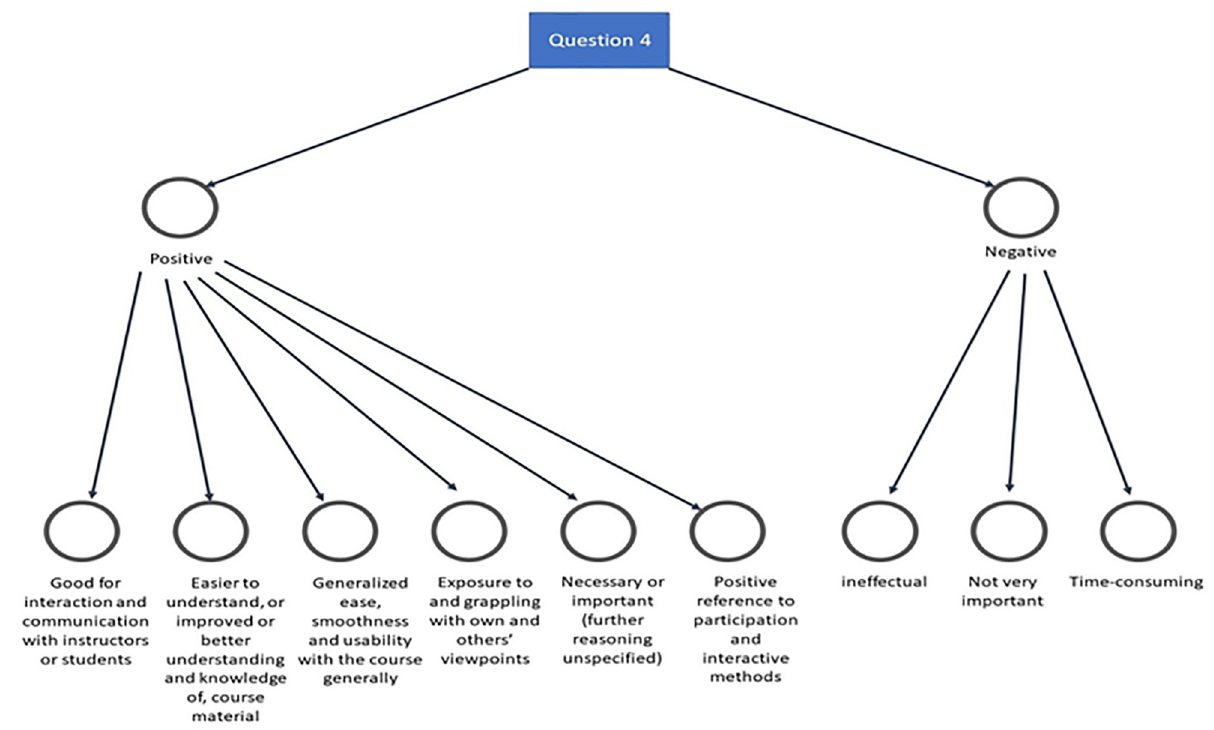
Fig 7. Reasons for students’ choice of tools for enhancing course delivery in the